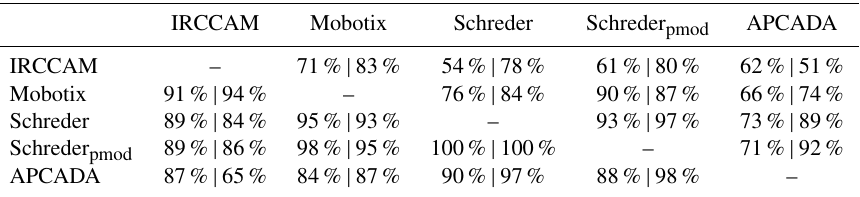
Figure 10. Residuals of the comparison of cloud fraction determined from IRCCAM images versus cloud fraction determined from Mobotix images for the following cloud classes: (a) Cu is cumulus, (b) Cc–Ac is cirrocumulus–altocumulus and (c) Ci–Cs is cirrus–cirrostratus. Table 6. Identical to Table 3, but on the left are the values for the summer months (June, July, August) and on the right are the values for the winter months (December, January,